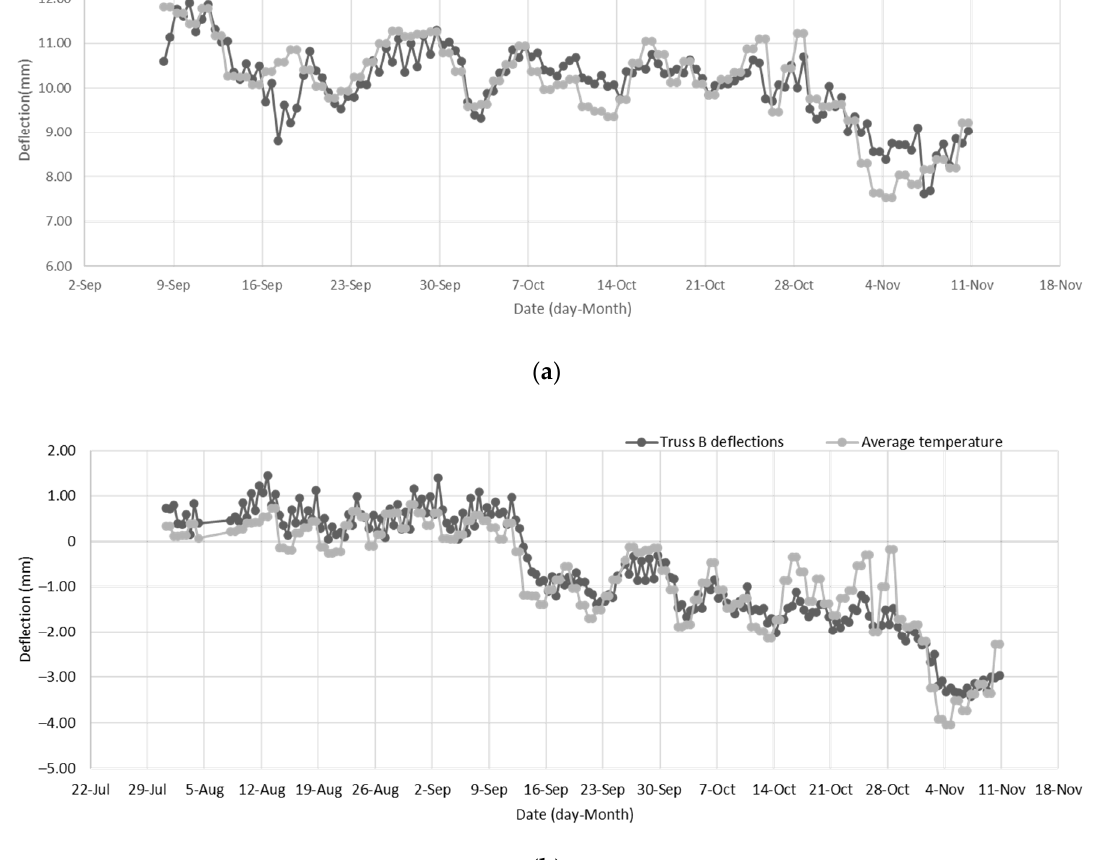
compared to twice-a-day temperature measurement.